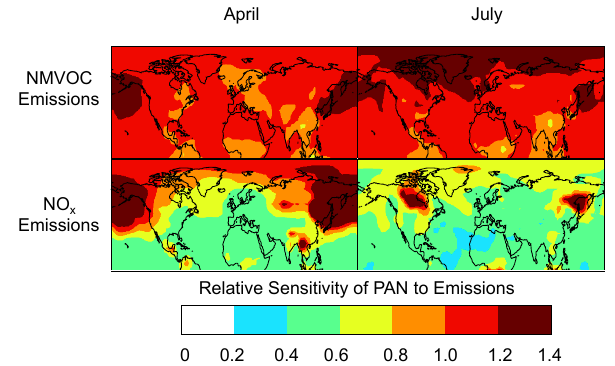
Fig. 4. Relative sensitivity of total column PAN concentrations to emissions of NO x and NMVOCs in April and July. The sensitivity is diagnosed as 1 PAN/ 1E , where 1 PAN is the change in monthly mean PAN column concentrations resulting from a 20% decrease 1E in global emissions of either NMVOCs (top) or NO x (bottom), including all sources and sustained year-round. Zero indicates no sensitivity, while one indicates 1 : 1